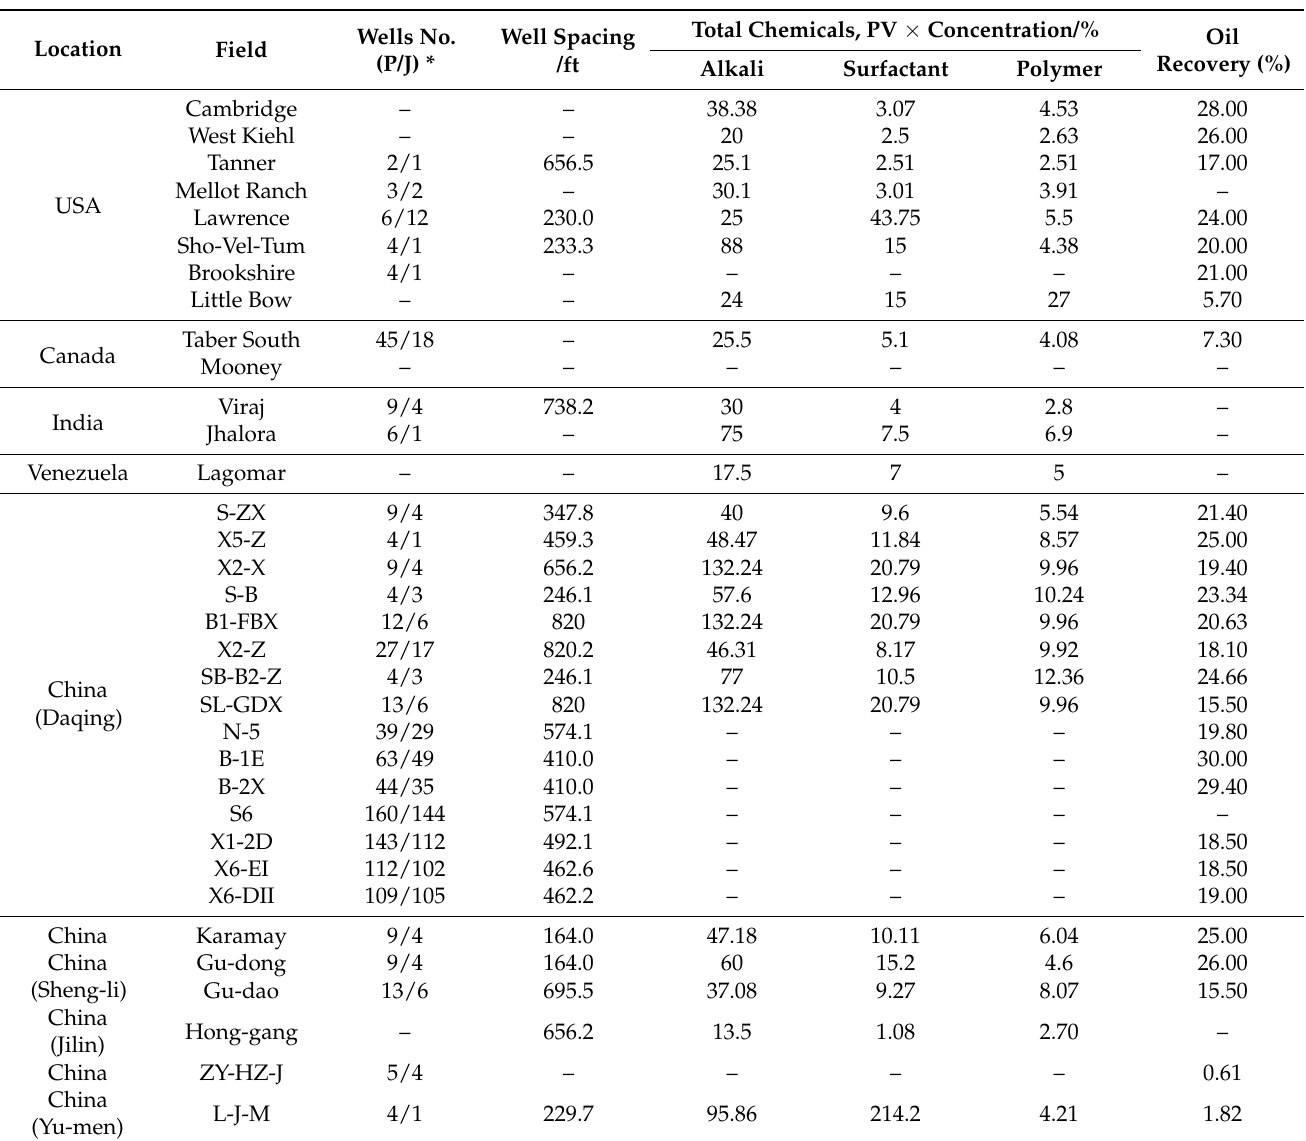
Table 2. Summary of recent ASP field